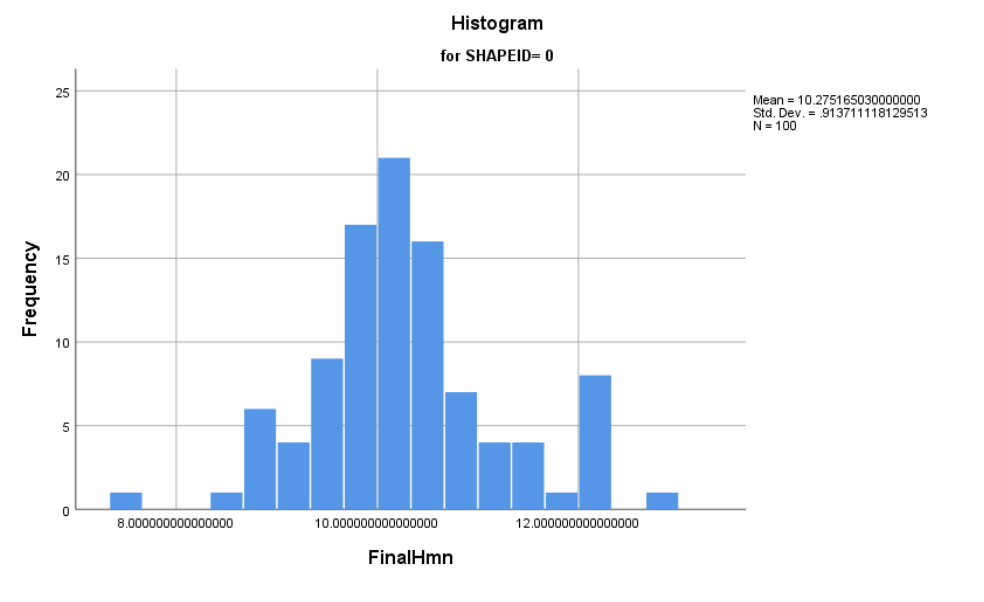
Figure A1. Shrink height adjustment for 10 mm.